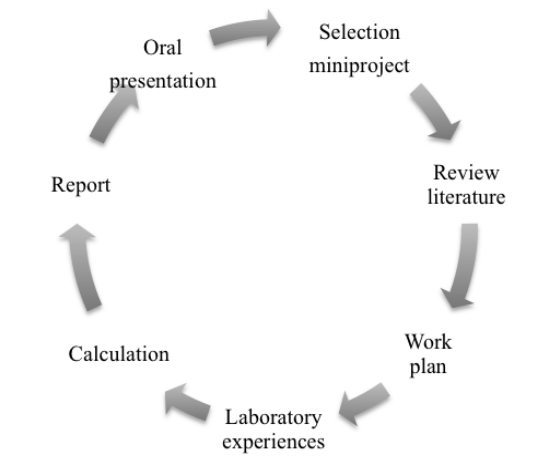
Figure 1. Task-time.